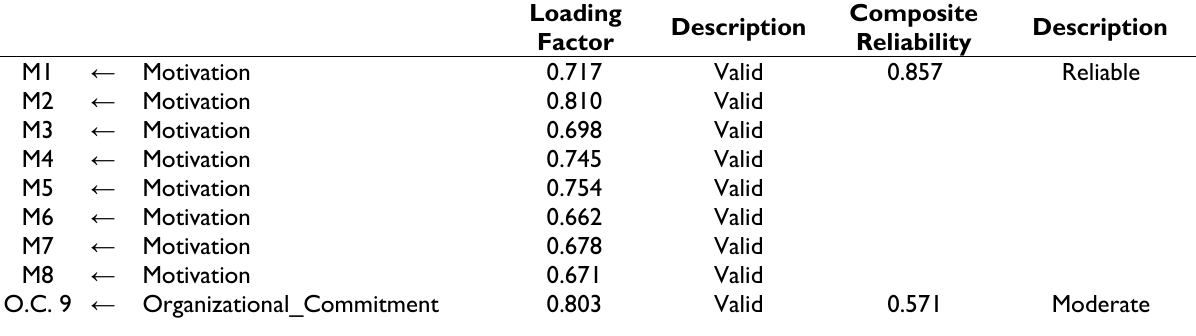
Table 2. Standardized Loading Factor on The Construct of Motivation, Organizational Commitment, and